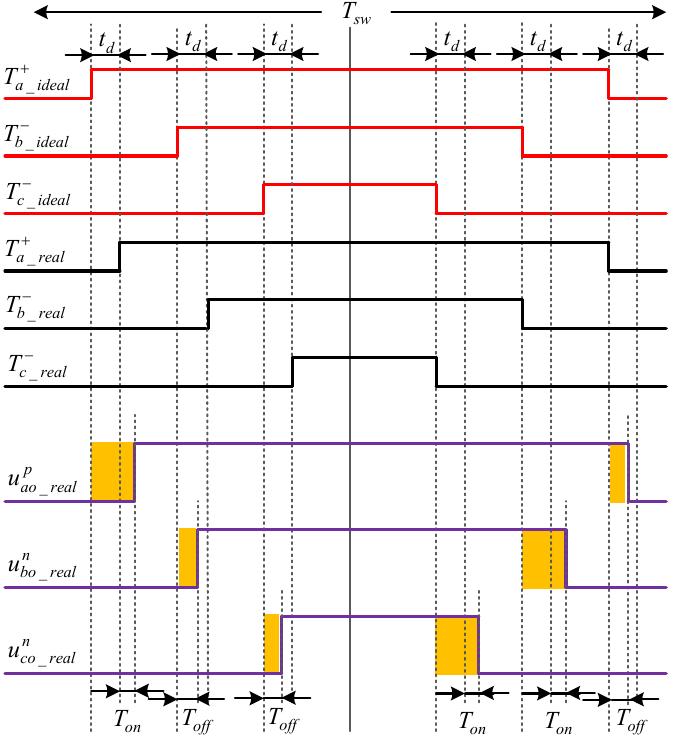
Figure 5. Analysis of time delays effect of the inverter switching devices (depicted in yellow color) during sector I.